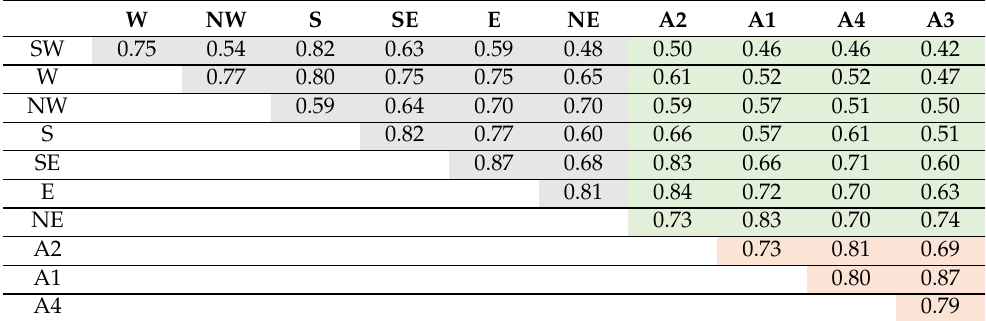
Table 4. Pairwise correlation coefficients between variations Aqua MODIS daily aerosol optical depth at 550 nm (AOD 550 ) over the seven cells of the Urmia Lake region in 2002–2021 (all statistically significant at p = 0.05). Correlation coefficients between AOD 550 variations: over the cells in the Urmia Lake region only are colored with gray; over the cells in the Urmia Lake region and over additional cells east from the Urmia Lake region are colored with green; over the additional cells only are colored with